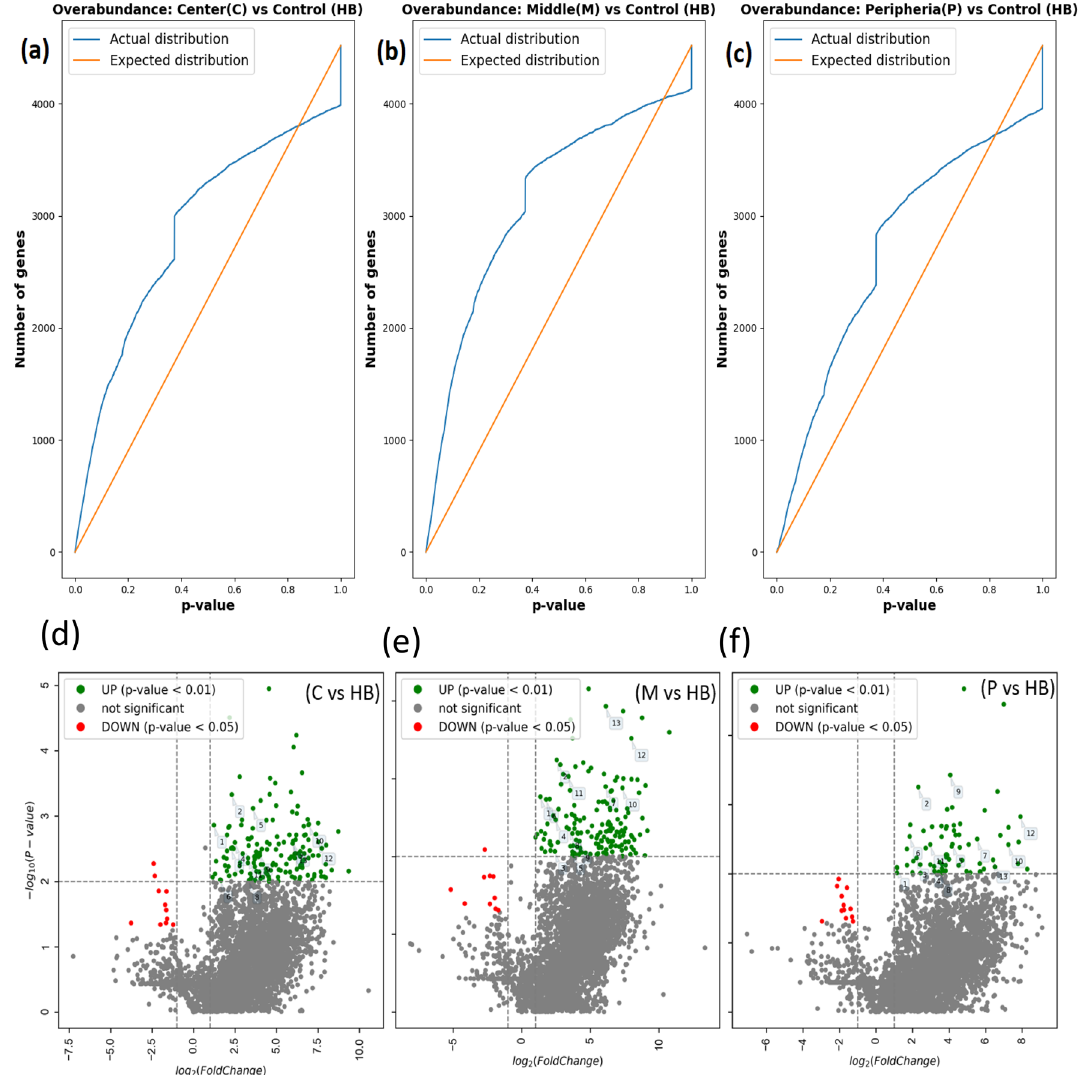
and 4,519 proteins extracted by e-biopsy per sample were analyzed. ( a ) 4T1 center versus healthy breast. ( b ) 4T1 middle versus healthy breast. ( c ) 4T1 periphery versus healthy breast. ( d , e ) Volcano plots showing the fold change difference of protein expression. ( d ) 4T1 center versus healthy breast. ( e ) 4T1 middle versus healthy breast ( f ) 4T1 periphery versus healthy breast. Numbers on the plot address corresponding rows in Table